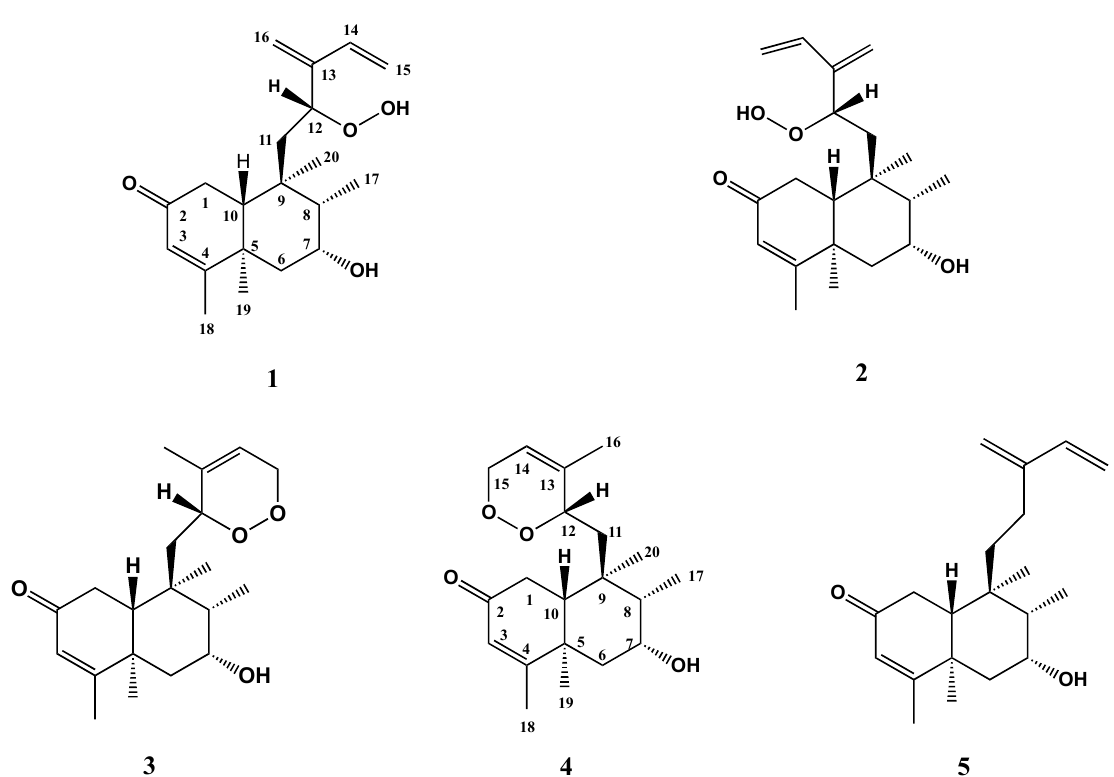
Figure 1. Structures of the isolated diterpenes from Stachys aegyptiaca.